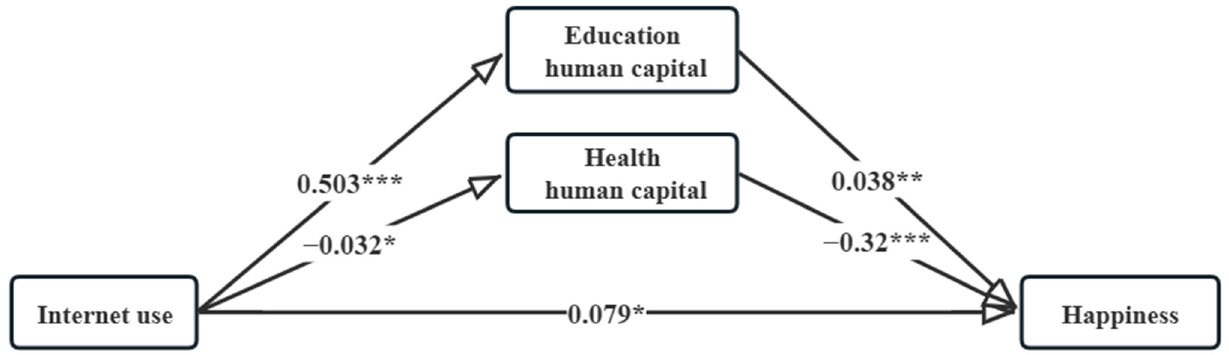
Figure 1. The Mediating Relationship Between Internet Use and Happiness. * p < 0.05, ** p < 0.01, *** p <